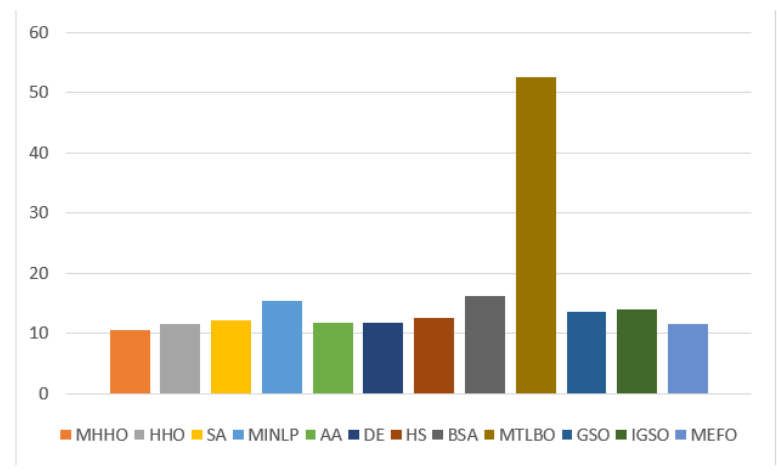
Figure 7. Algorithm-wise objective function comparison for 15-bus network. Table 8. Percentage of improvement by MHHO for 15-bus network. Algorithm O.F.(s)